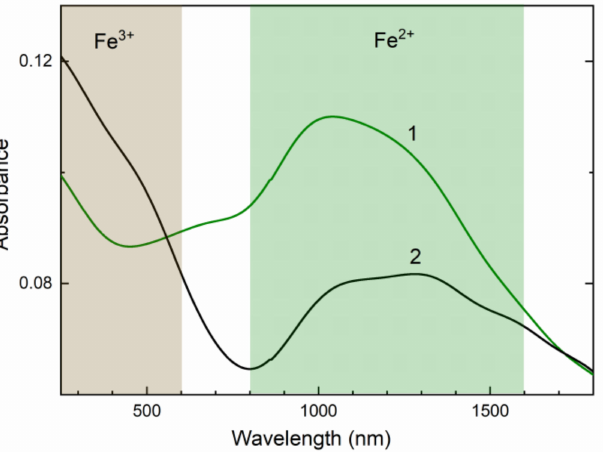
Figure 8. Diffuse light UV/Vis/NIR absorption spectra of initial (green curve 1) and annealed (black curve 2)